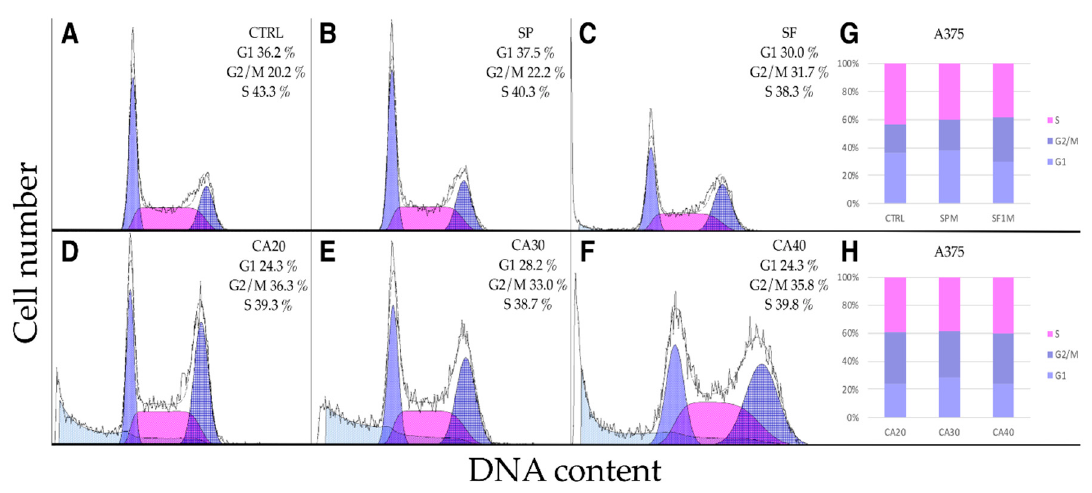
Figure 6. Cell cycle analysis of A375 cells. ( A ) Control DMSO treated cells. Cells treated 24 h with 100 µ g / mL of ( B ) SP, ( C ) SF methanolic extracts or ( D – F ) CA at concentrations of 20, 30 and 40 µ g / mL. ( G , H ) SF